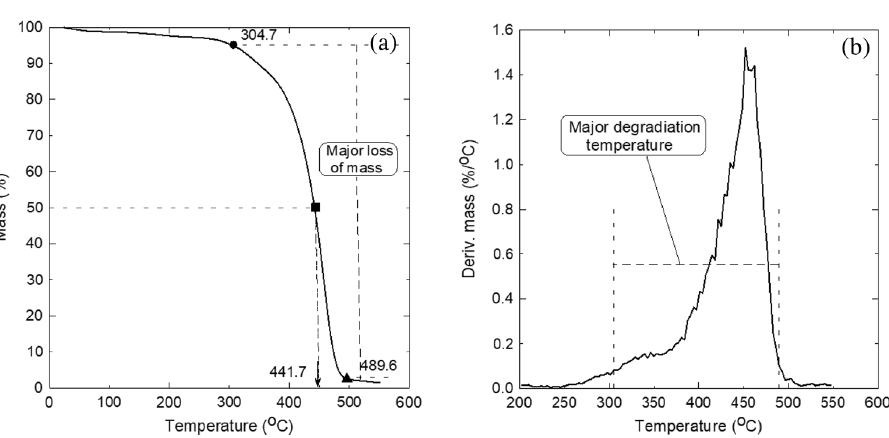
Figure 13. Thermal stability analysis of the elastic ear loops (sample number 5) showing the important points of degradation and decomposition, ( a ) thermogravimetric analysis (TGA) and ( b ) derivative thermogravimetric analysis